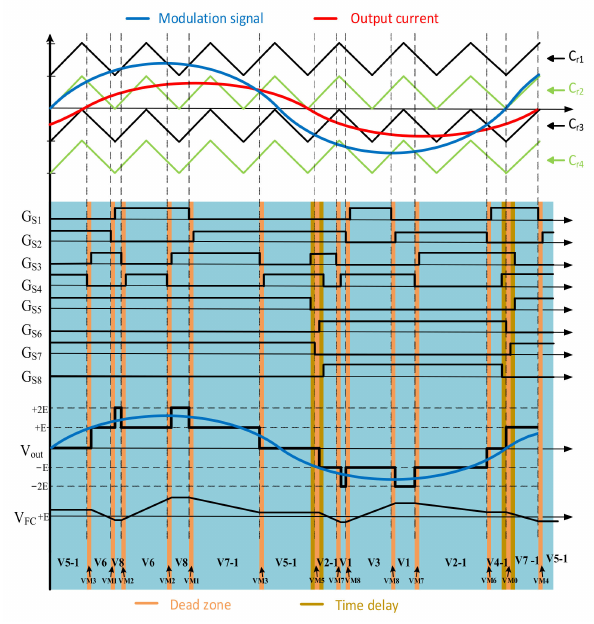
Figure 12. The waveform of the floating capacitor